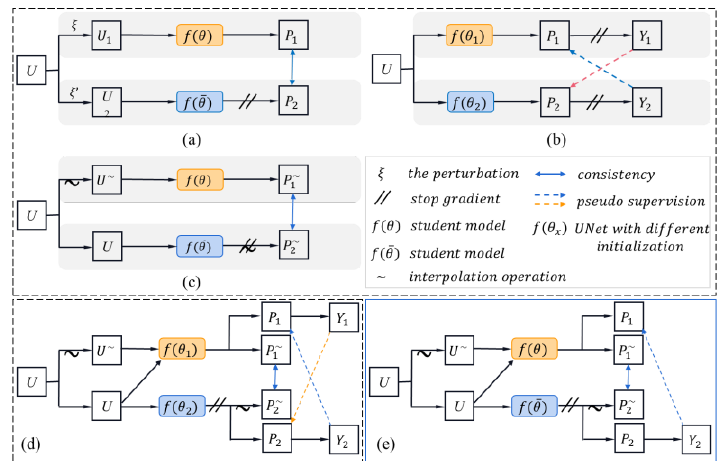
Figure 4. Illustration of the diagrammatic architecture for related works; only the semi-supervised part is given here. ( a ) mean teacher, ( b ) cross-pseudo-supervision, ( c ) interpolation consistency training, ( d ) cross-pseudo-interpolation consistency learning, ( e ) pseudo-interpolation consistency training. ( a – c ) are the related advanced works, ( d – e ) are the proposed schemes. U denotes the unlabeled data, P is the prediction map, Y represents the pseudo-label, 𝑓(𝜃 1 ) and 𝑓(𝜃 2 ) represent network with different initialization. MT can be considered as the baseline for all work. Here, MT’ is used to represent two networks with different initialization. Therein, ( b ) can represented by MT ’ + CP, ( c ) can be denoted as I + MT, ( d ) can be denoted as MT ’ + CP + I , and ( e ) can be denoted as I + MT + P.